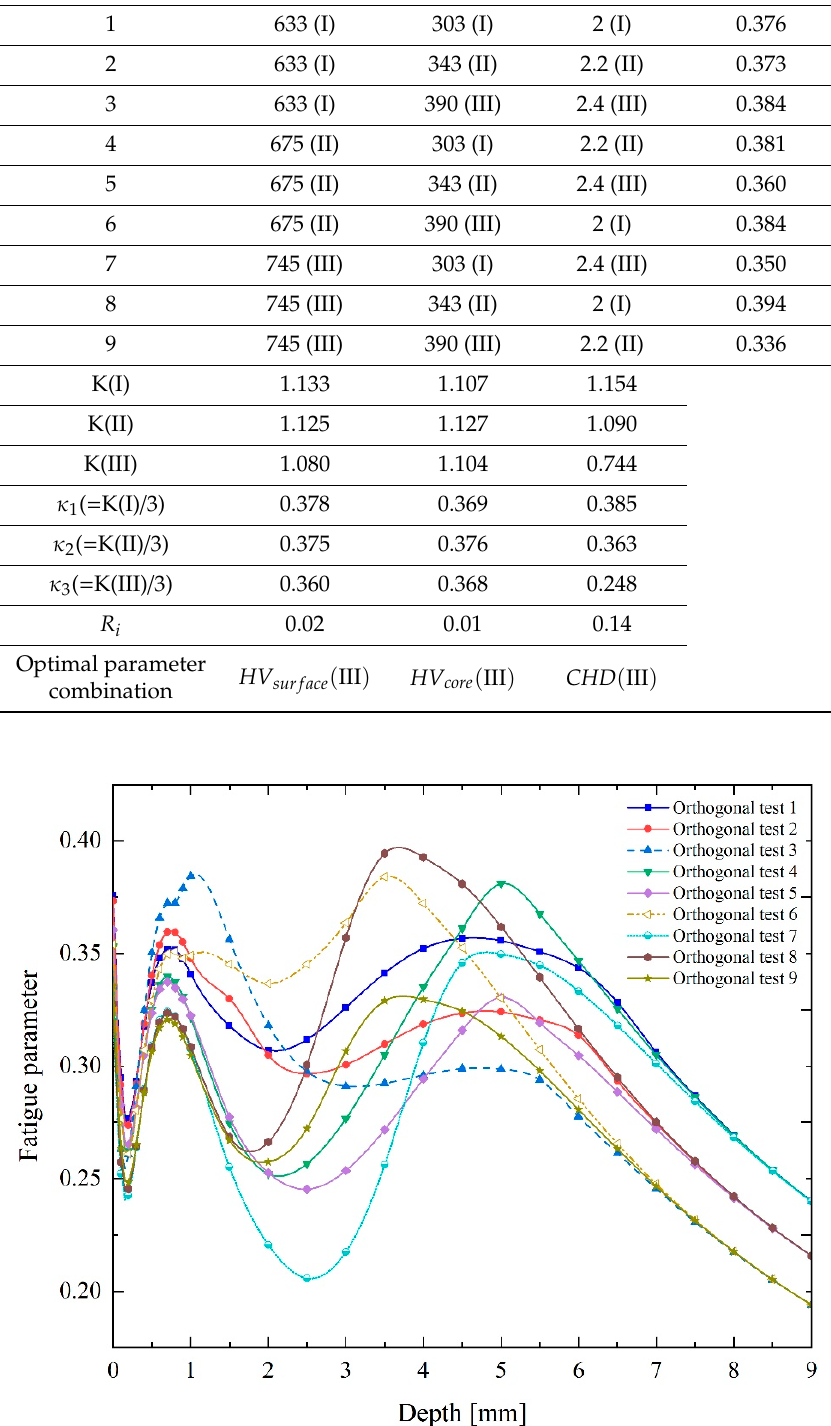
Table 4. Three-parameter orthogonal test table. Orthogonal Test